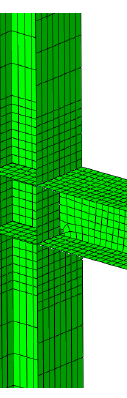
Figure 7. Finer mesh size at used in the connection region.